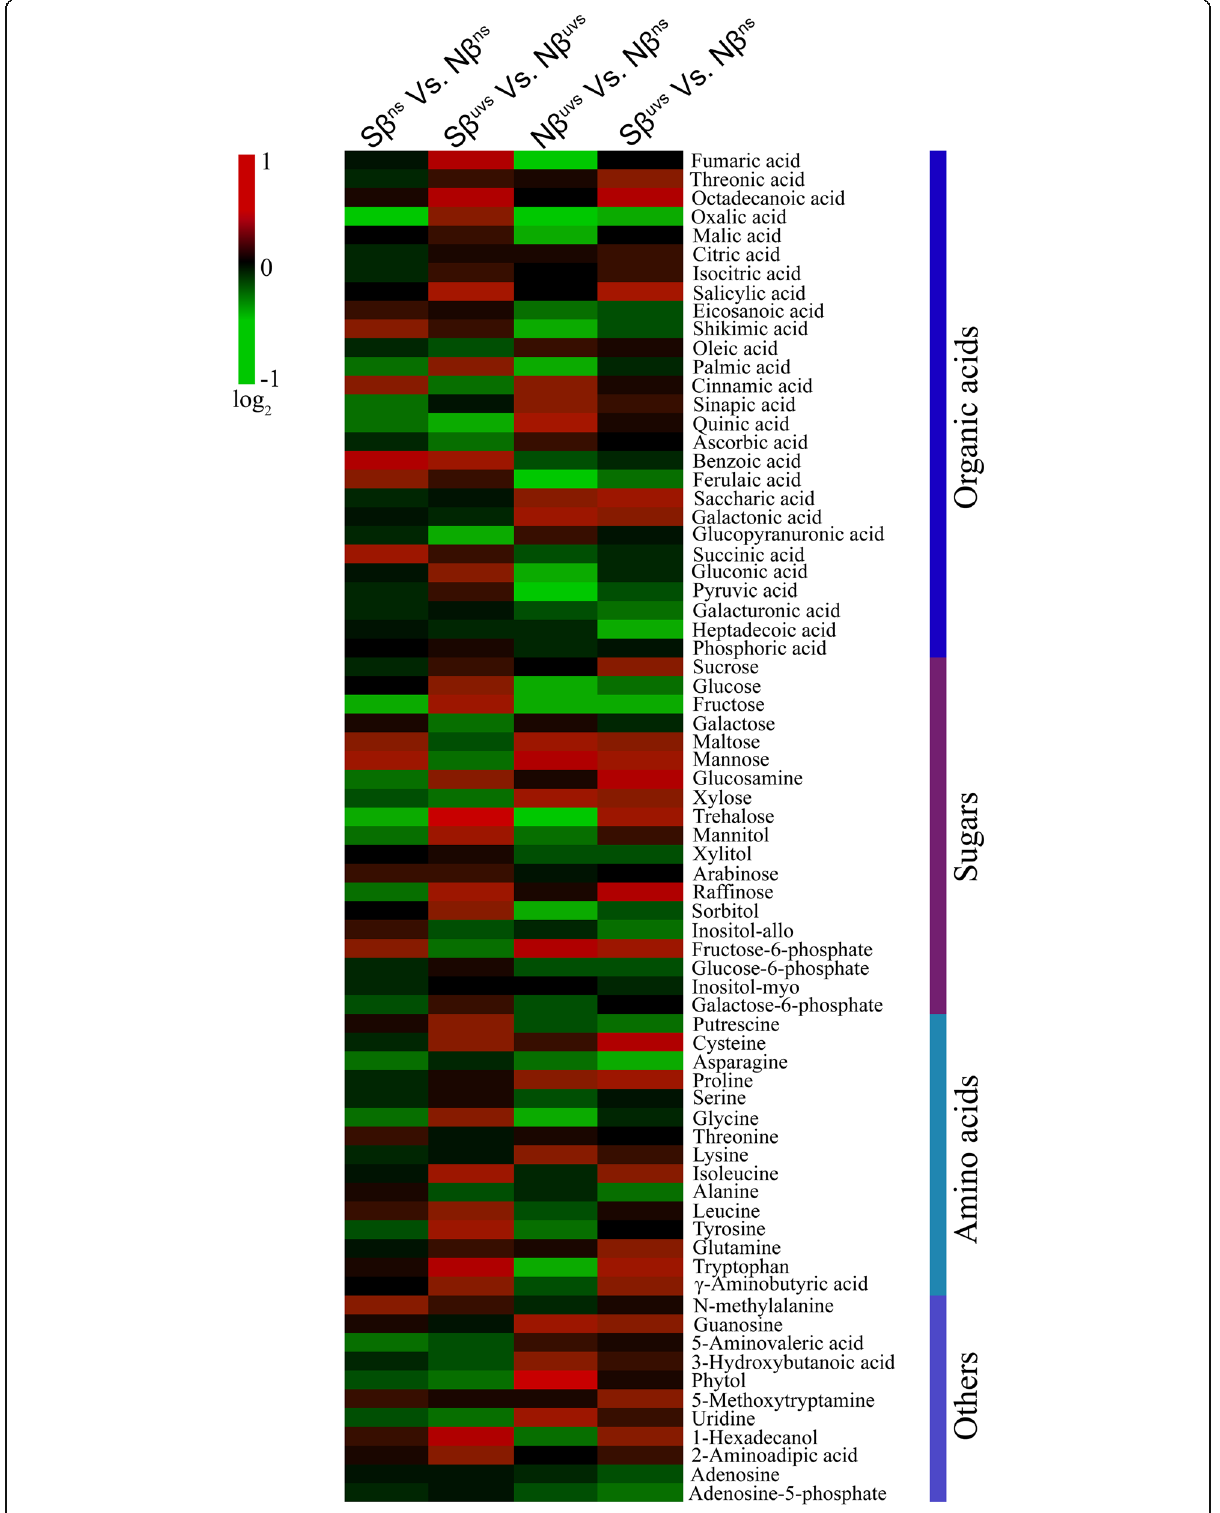
Fig. 6 Heat map of 72 key metabolites in N β and S β plants under non-stress and UV-B stress conditions. The heat map shows the log 2 fold change ratios, where red color codes representing upregulation whereas green color codes show downregulation of metabolites. The data is representative of two independent